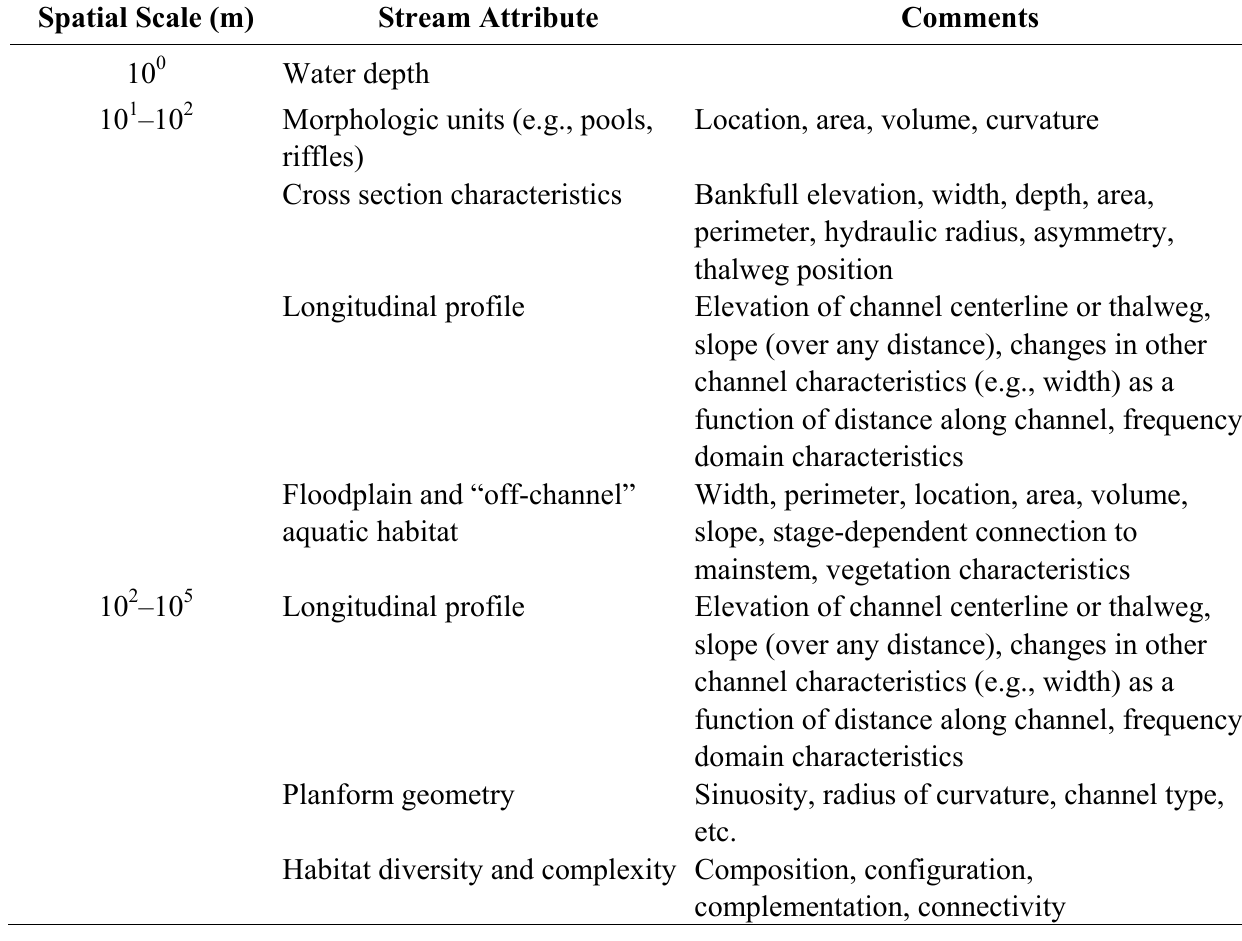
Table 3. Channel attributes mappable using the